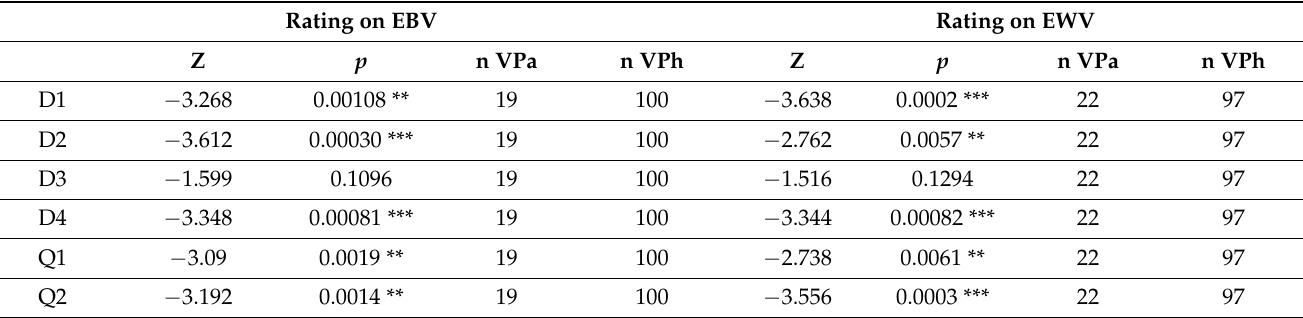
Table 4. Differences in the domains of the researched groups in terms of physiological/pathological visus.